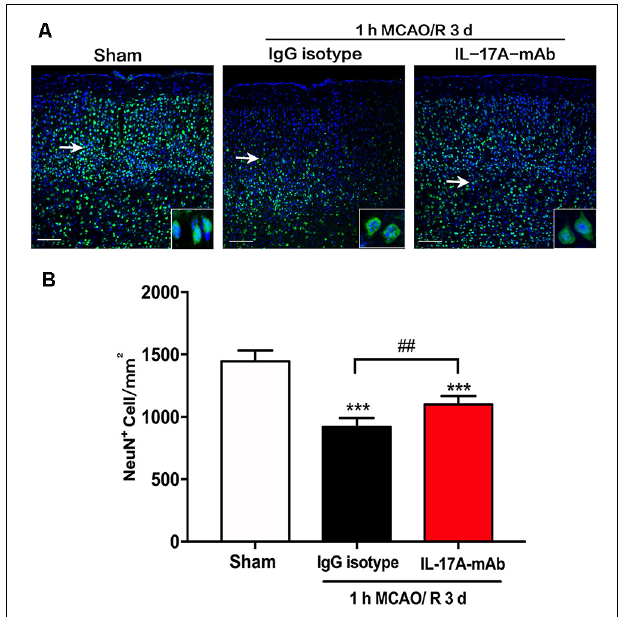
FIGURE 2 | Effect of IL-17A-neutralizing mAb on neuron loss in peri-infarct region of mice with ischemic stroke. (A) The representative immunofluorescent staining results showed the effect of IL-17A-neutralizing mAb on NeuN positive numbers in peri-infarct region of mice following 1-h MCAO/R 3 days’ treatment (scale bar = 100 µ m). (B) Statistical analysis results demonstrate that the i.c.v. injection of IL-17A-neutralizing mAb (2.0 µ g) could significantly inhibit the NeuN positive cell loss when compared with that of 1-h MCAO/R 3 days + IgG isotype group. Data are presented as mean ± SEM; *** p < 0.001 vs. sham group; ## p < 0.01 vs. 1-h MCAO/R 3 days + IgG isotype group ( n = 6 per group).